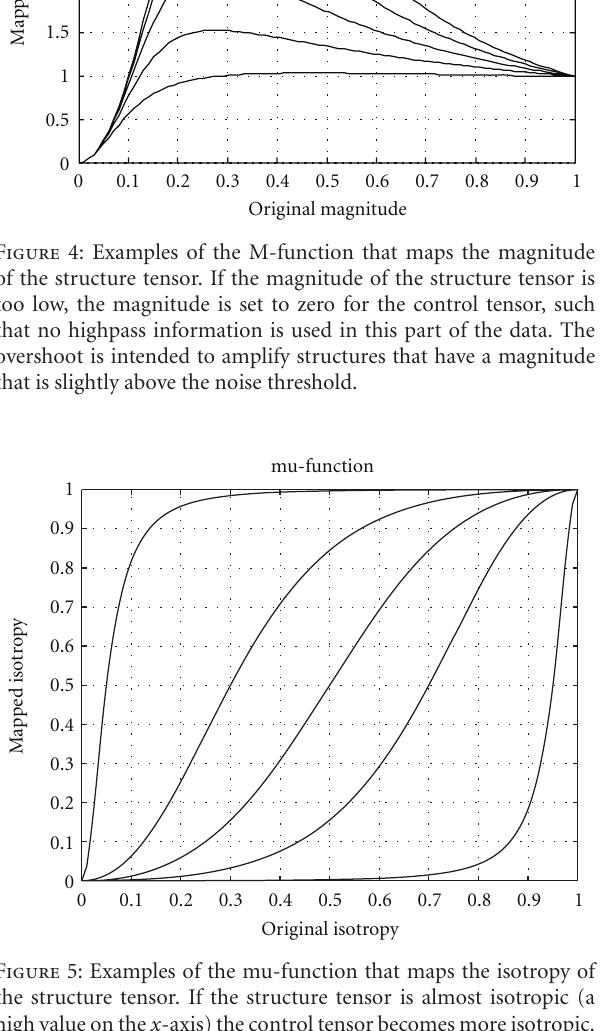
Figure 5: Examples of the mu-function that maps the isotropy of the structure tensor. If the structure tensor is almost isotropic (a high value on the x -axis) the control tensor becomes more isotropic. If the structure tensor is anisotropic (a low value on the x -axis) the control tensor becomes even more